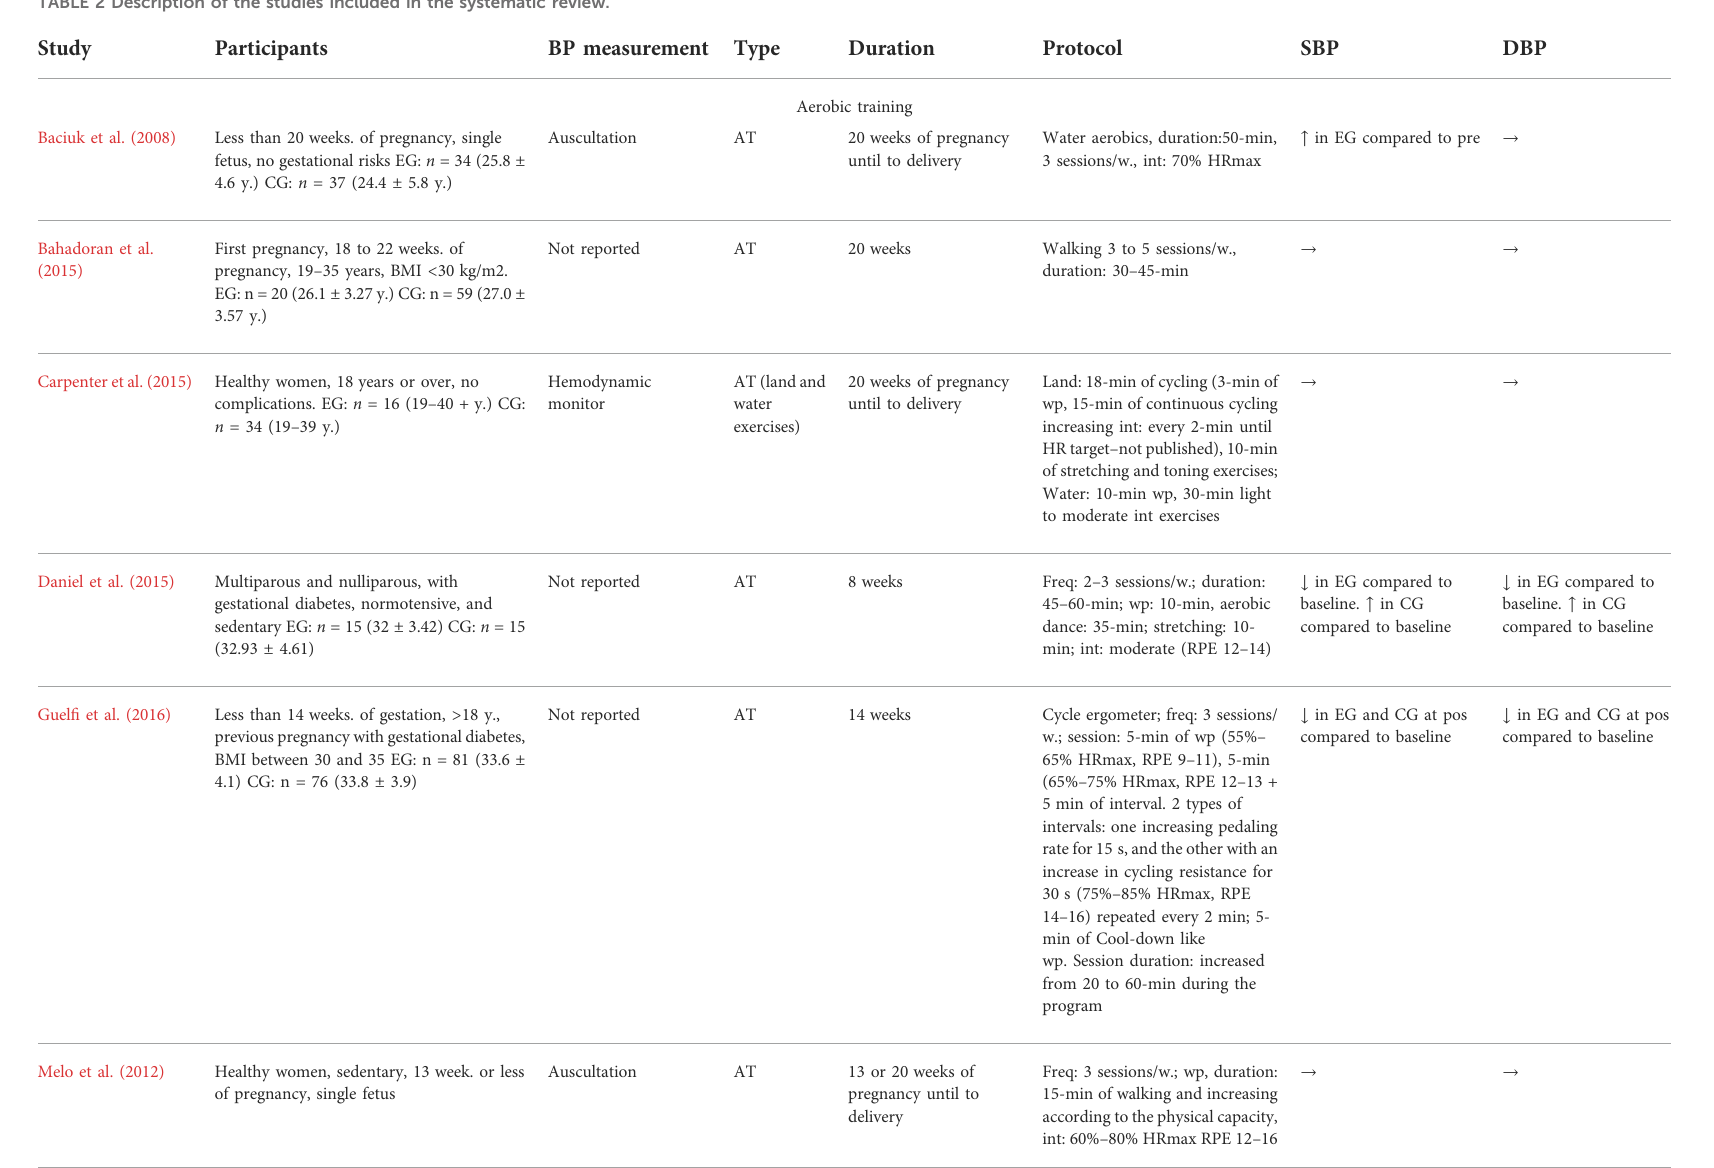
TABLE 2 Description of the studies included in the systematic